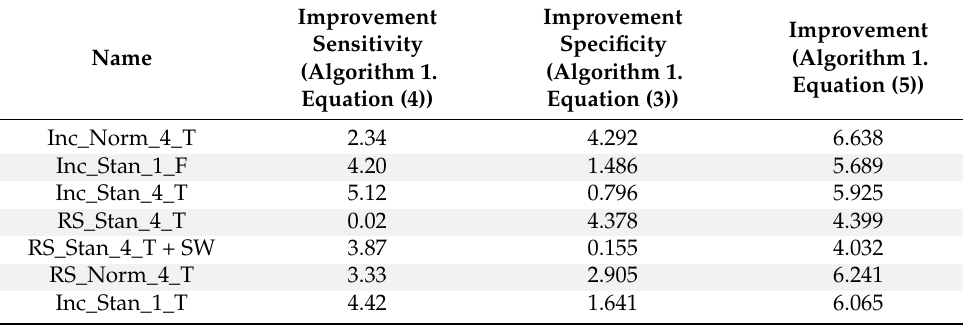
Table 8. Corresponding improvements for